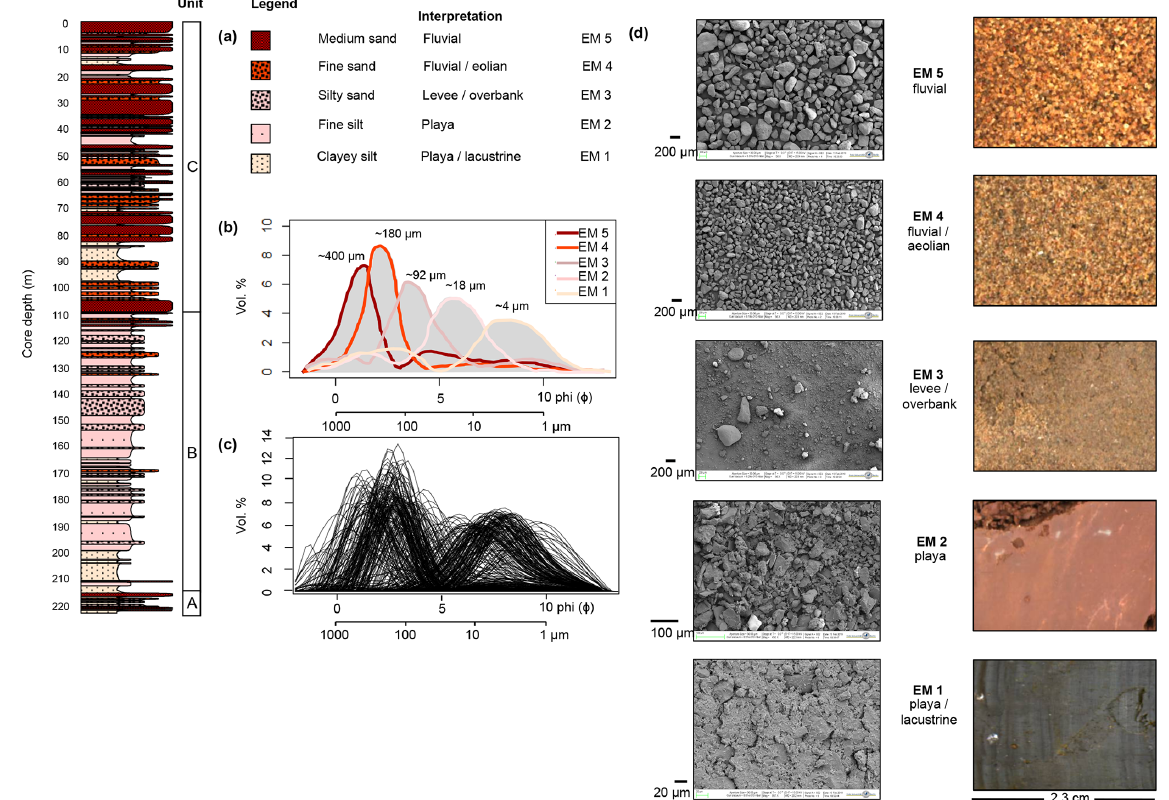
Figure 2. (a) GN200 graphic log with sediment units and litho codes deduced from grain size dominating endmembers (EM) (based on Dietze and Dietze, 2019). Interpretation of depositional environment is added. (b) Illustrated endmember calculation results and (c) sample population (see also Appendix). (d) SEM images and core scan examples for the main sediment types as defined by endmember